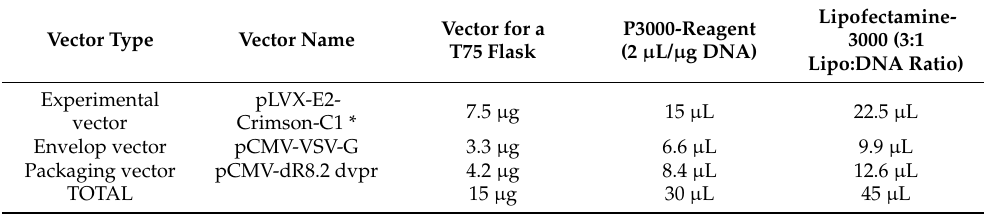
Table 2. General protocol for preparation of Lipofectamine transfection mixtures